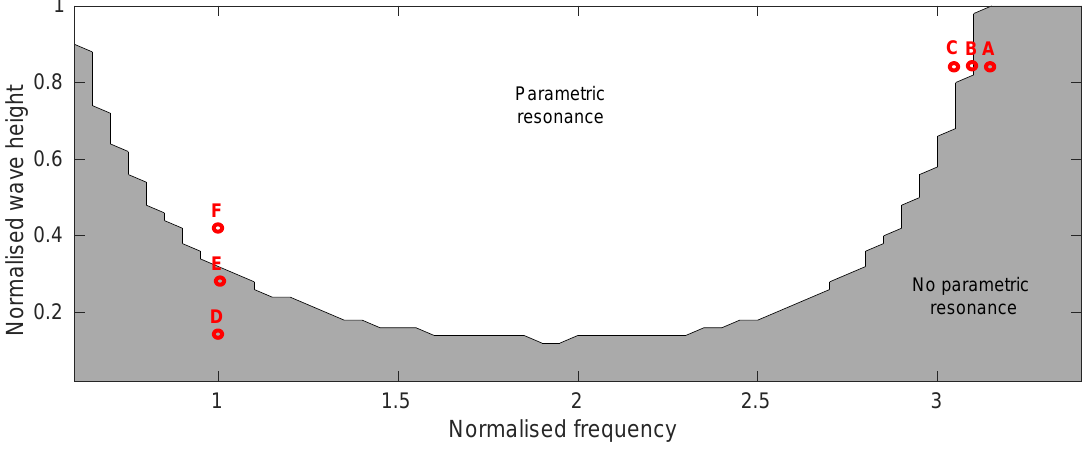
Figure 11. The amplitude and frequency range spanned by the polychromatic waves’ test cases. The region in which parametric resonance was observed is shown in